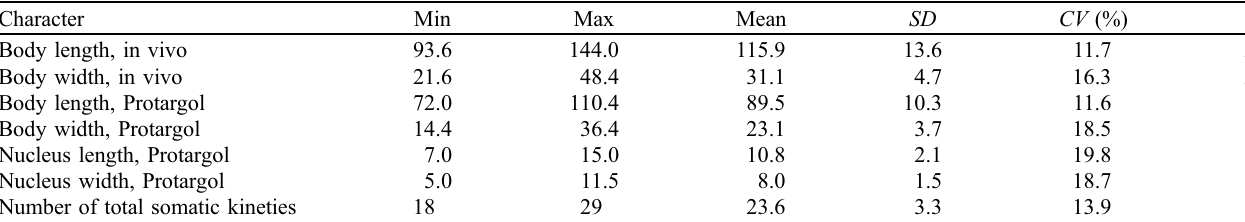
Table 2. Morphological comparison among P. pingi and other similar species of Protoopalina . Species BL BW N n NL NW N s Source of data P. pingi